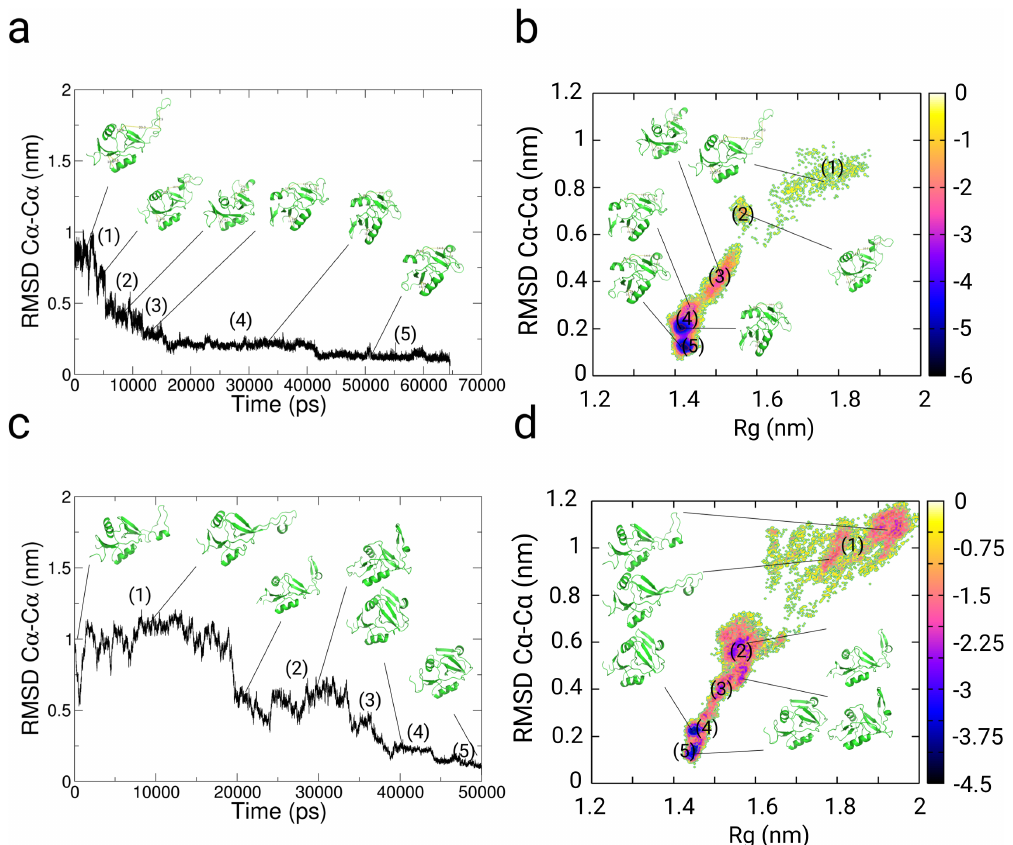
Figure 5. Results from restrained simulations of the Killer Cell Lectin-like Receptor Subfamily B Member 1A (NKR-P1A) along multiple path-dependent biasing variables with chemical cross-linking restraints from ref. [89] (PDB: 3m9z as starting structure). ( a , b ) Results from enhanced restrained simulations using the path-dependent biasing approach in implicit solvent. ( c , d ) Results from enhanced restrained simulations along multiple path-dependent biases in explicit solvent. ( a , c ) RMSD C α − C α to the final structure of each simulation. ( b , d ) Free energy landscape as function of RMSD C α − C α and the radius of gyration (Rg). Energy values on the color bar are in units of k B T . The protein relaxes quickly out of the extended conformation in both simulations within few ns and adopts 5 different compact states, where the loop region (residues: Arg157-Ser188) are packed to the β -strand interface (residues: Ser188-Asn203) and parts of the second N-terminal helix (residues: Gln135-Ile145) of the